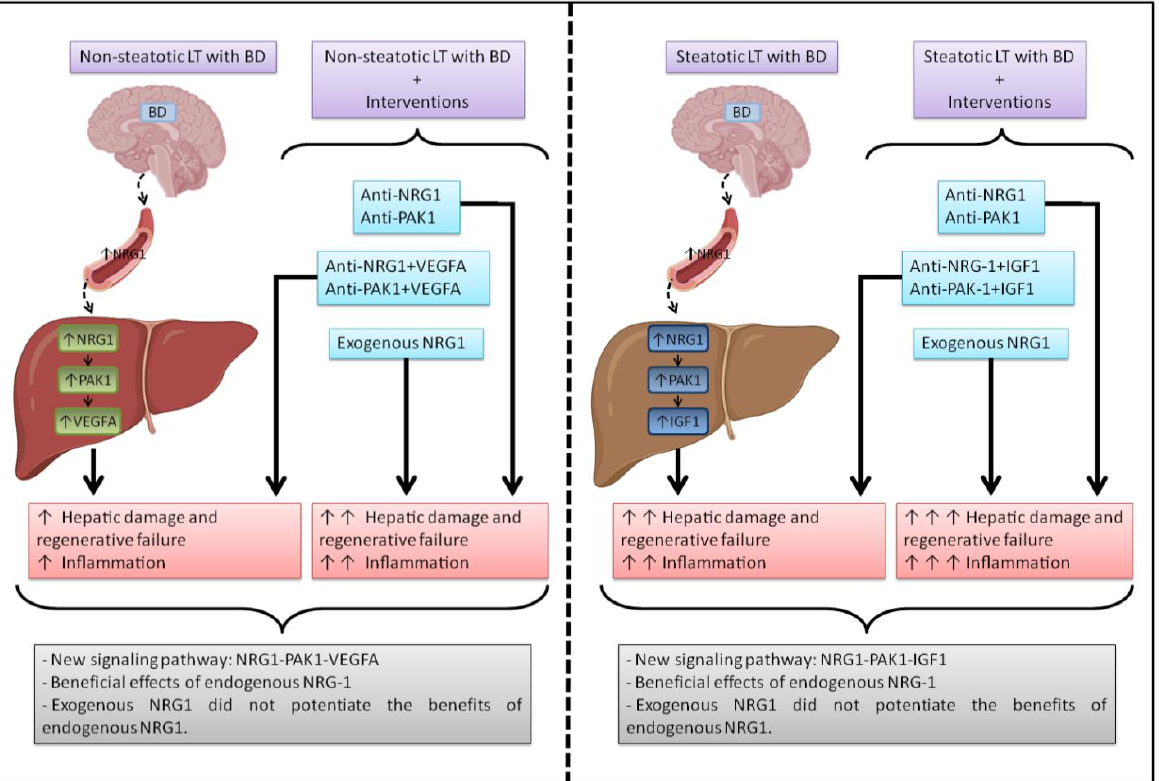
Figure 6. A schematic representation of the new proposed signaling pathways detected in this study, in steatotic and non-steatotic LT, and the effects of the different interventions and their outcomes.